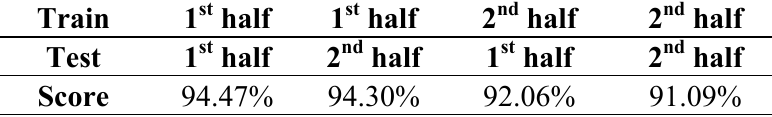
Table 3. RBRC retrieval rate when testing on half of the database.